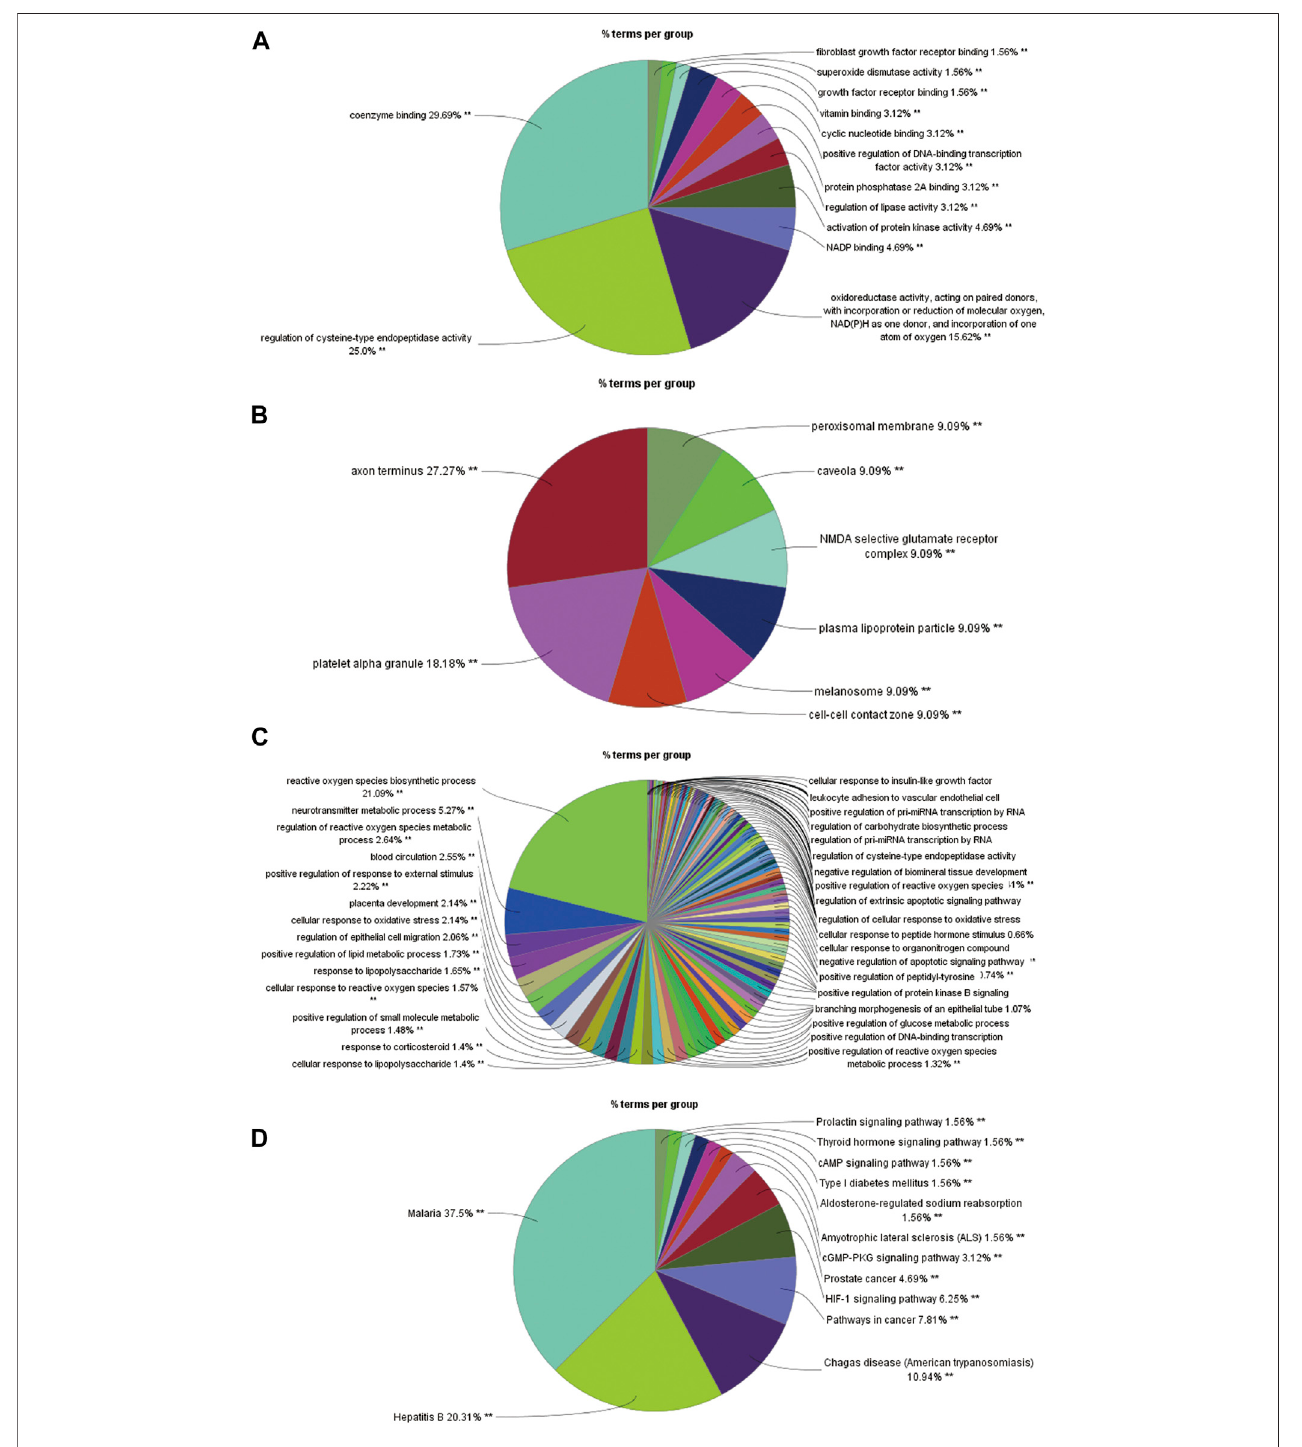
FIGURE7|(A) Histogramoftheresultsfromthemolecularfunctionalenrichmentanalysis( p ≤ 0.01). (B) Piechartoftheresultsfromthecellcomponentenrichment analysis( p ≤ 0.05). (C) Piechartoftheresultsfromthebiologicalprocessenrichmentanalysis( p ≤ 0.01). (D) Diagramoftheresultsfromthepathwayenrichmentanalysis ( p ≤